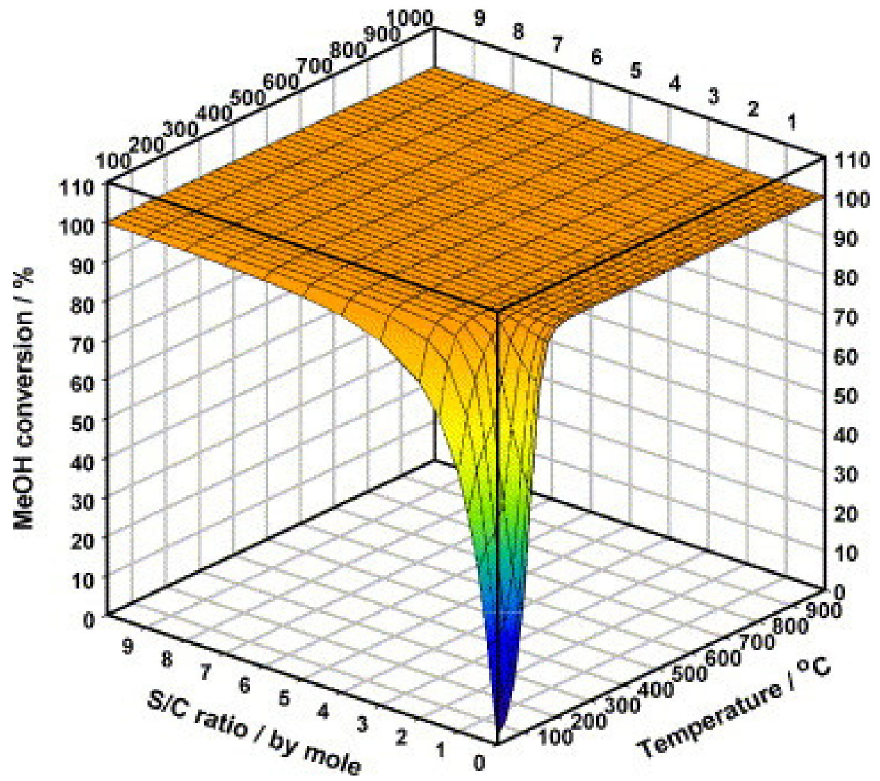
Figure 1. Equilibrium conversion of MeOH from SRM as a function of (S/C ratio and temperature. (Adapted from [61], copyright 2006,